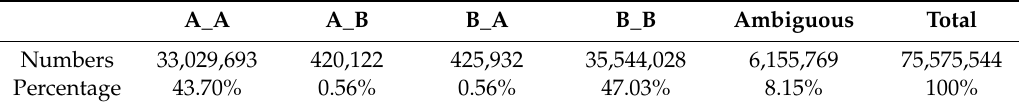
Table 1. Statistics of linker composition.